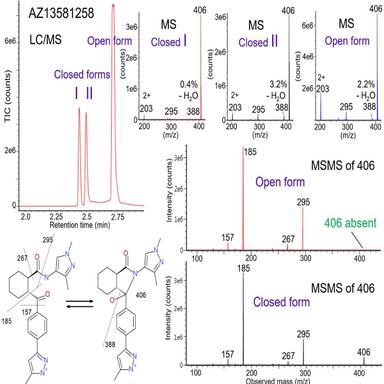
LC–MS and MSMS of open and closed forms of AZ13581258. Total ion current (TIC) chromatogram at top-left shows separation of the three tautomers under acidic conditions. The three MS-spectra at the top compare source fragmentation of the two ring-closed diastereomeric tautomers I and II with the open form. The two mass spectra below compare MSMS of open-form (top) and ring-closed tautomer I (below), highlighting the more fragile structure of the open tautomer even compared to the most fragile of tautomer I a